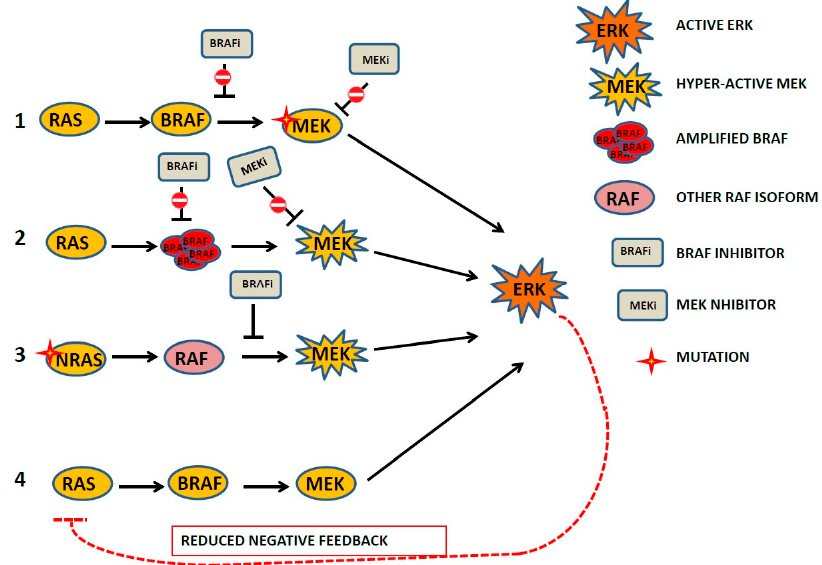
Figure 1. Synthetic representation of the main mechanisms leading to BRAF and MEK inhibitors